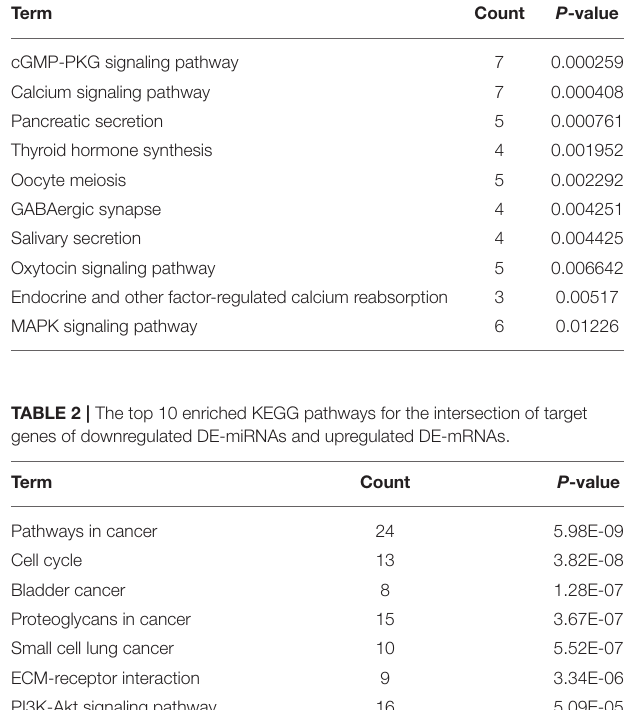
TABLE 1 | The top 10 enriched KEGG pathways for the intersection of target genes of upregulated DE-miRNAs and downregulated DEGs. Term Count